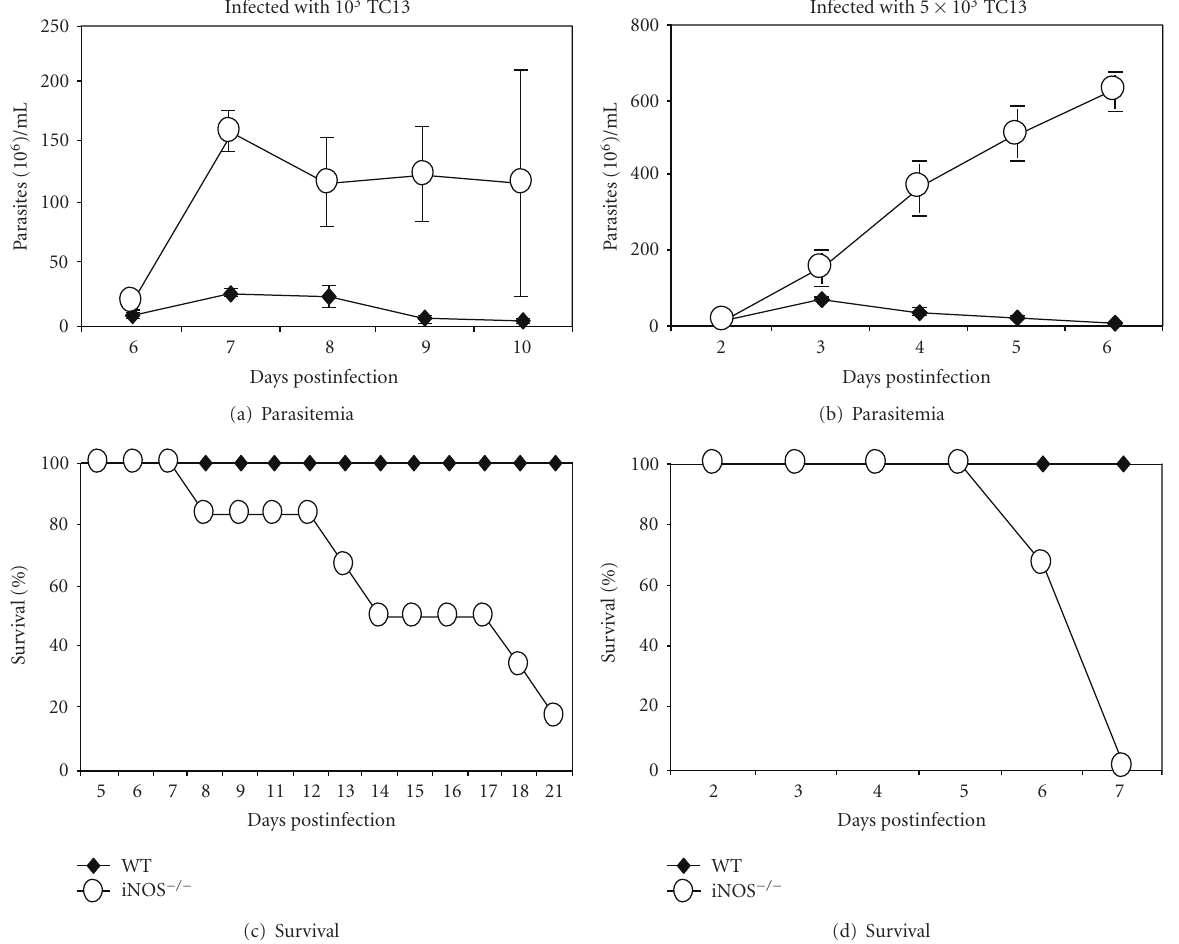
Figure 1: iNOS − / − mice are highly susceptible to infections by T. congolense : enhanced parasitemia and reduced survival time . Groups of 5 to 10WT or iNOS − / − C56BL/6 mice were infected with low (10 3 ) or high (5 × 10 6 ) doses of T. congolense TC13 and parasitemia and survival time were determined. The initial parasitemia is about 5-fold higher in iNOS − / − mice infected with 10 3 T. congolense than in infected wild- type (WT) mice (a) and more than100-fold higher in iNOS − / − mice infected with 5 × 10 6 T. congolense than in infected WT mice (b). WT mice infected with either dose survive for more than 30 days (the duration of observation period) (c). iNOS − / − mice infected with 10 3 T . congolense have a mean survival time of 14 ± 7 days and iNOS − / − mice infected with 5 × 10 6 T. congolense survive for only 6 . 8 ± 0 . 1 days (c).